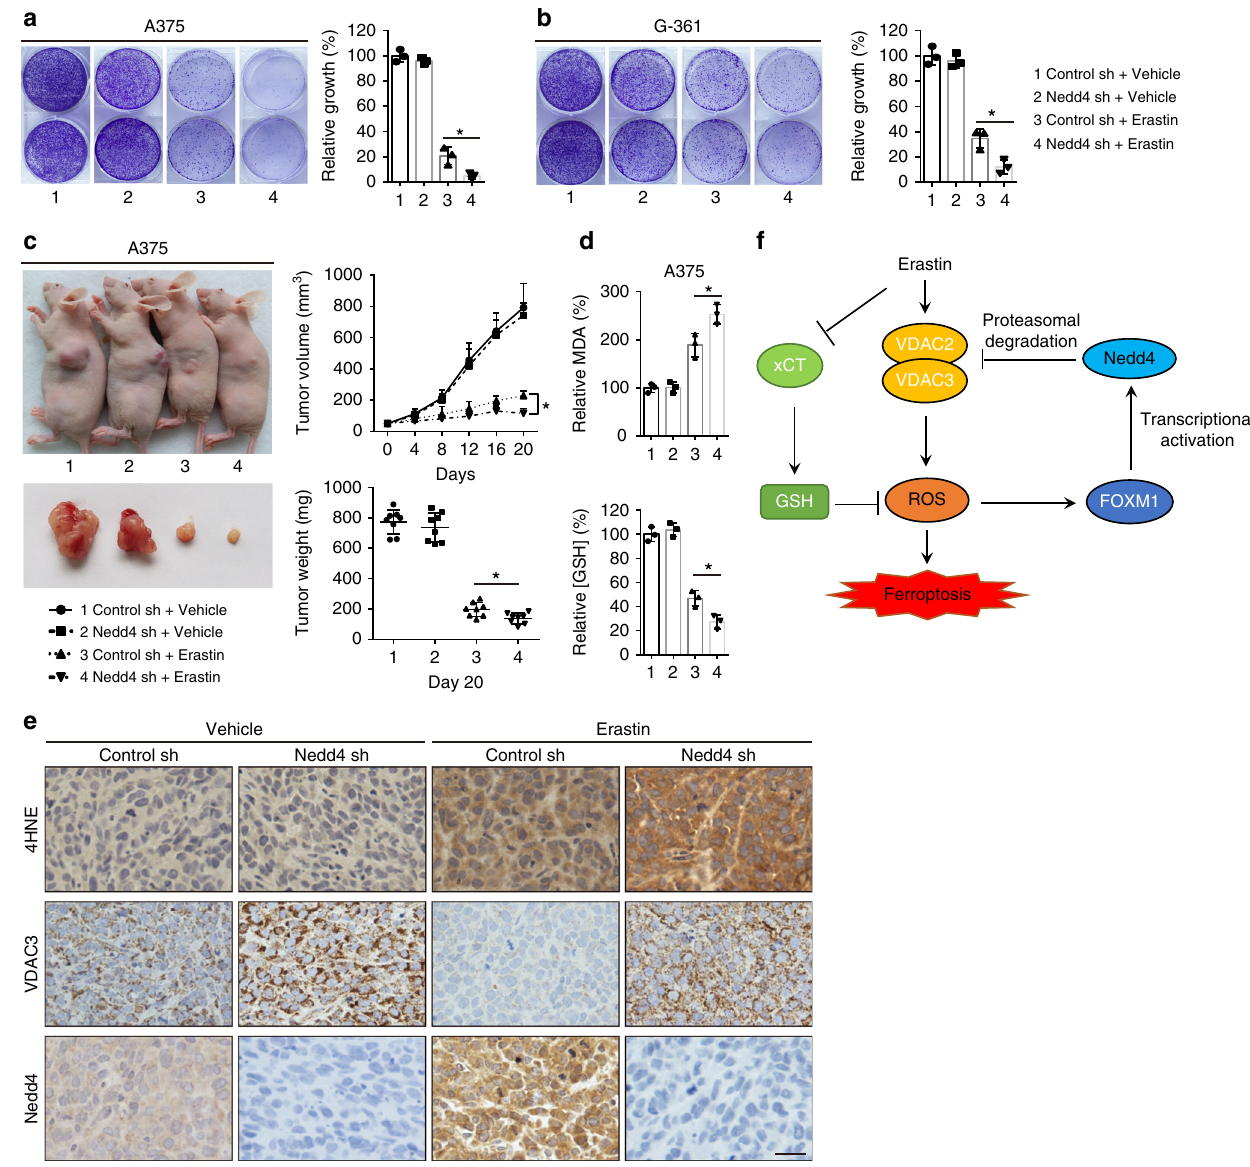
Fig. 7 Knockdown of Nedd4 suppresses erastin resistance in vitro and in vivo. a , b Colony formation assay of indicated A375 ( a ) and G-361 ( b ) cells. Cells were treated with erastin (5 µ M) for 24 h and were grown without erastin for 10 days. For each cell line, all dishes were fi xed, stained, and photographed at the same time. c , d Knockdown of Nedd4 enhanced erastin-induced ferroptosis in vivo. The 7-week-old immunode fi cient nude mice (eight mice per group) were injected subcutaneously with indicated A375 cells (5 × 10 6 cells per mouse) and treated with erastin (15 mg per kg intraperitoneal, twice every other day) when the tumor volume reached 50 mm 3 . Tumor volume was calculated every 4 days ( c ), and the tumor mess was measured at day 20 ( c ). The relative levels of MDA and GSH of indicated tumors were measured ( d ). e Immunohistochemistry analysis of VDAC3, Nedd4, and 4HNE of tumor xenografts. Scale bar, 50 µ m. The experiment was repeated twice independently with similar results. f Schematic depicting the regulation of VDAC2/3 by FOXM1 and Nedd4 during ferroptosis in melanoma cells. Erastin activates FOXM1 to induce the transcription of Nedd4. Increased level of Nedd4 degrades VDAC2/3 and suppresses ferroptotic cell death. Data are mean ± SD from three independent experiments. Comparisons were made using Student ’ s t test. * p <